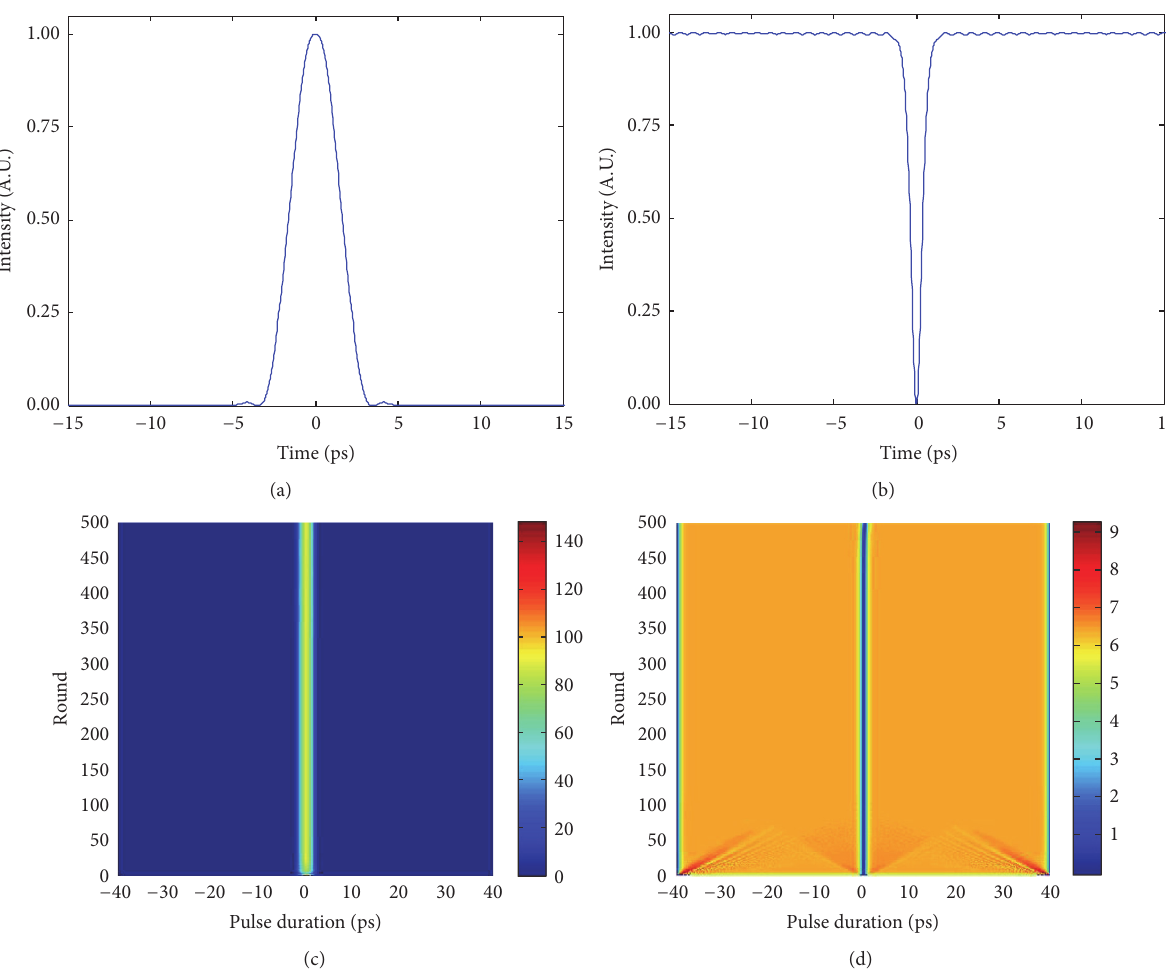
Figure 2: (a) Temporal profile of the dissipative soliton at 𝐸 sat = 460 pJ. (b) Temporal profile of the dark soliton at 𝐸 sat = 460 pJ. (c) Dynamic evolution of dissipative soliton. (d) Dynamic evolution of dark